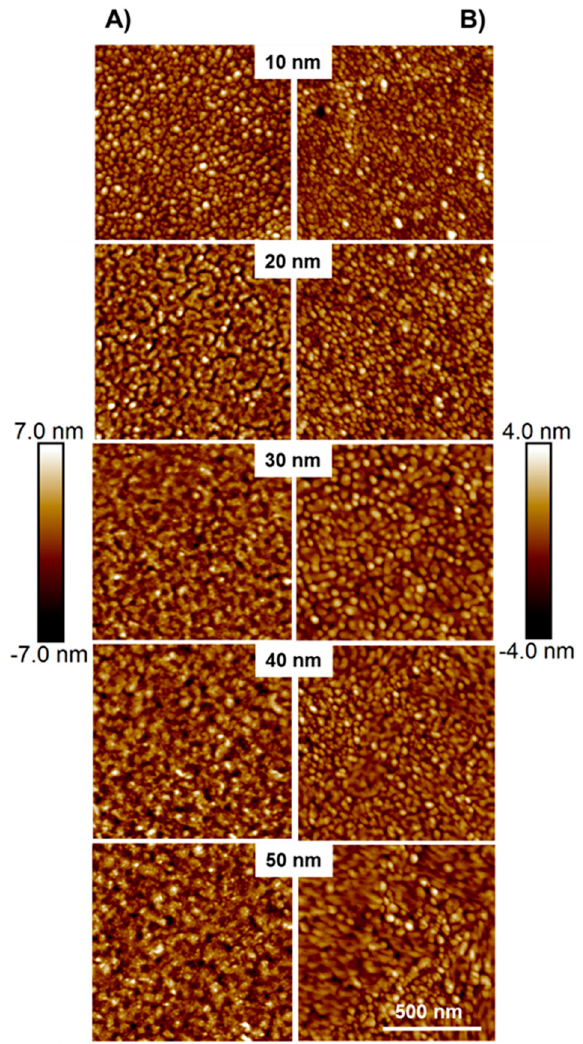
Figure 9. AFM topography images (1 µm × 1 µm) of evaporated Ag layers with different thickness on PC. Column ( A ) shows evaporation with no sample movement during deposition and column ( B ) shows evaporation with rotating the samples during deposition. The z-scales correspond to the images in the ( A ) or in the ( B ) column, respectively.